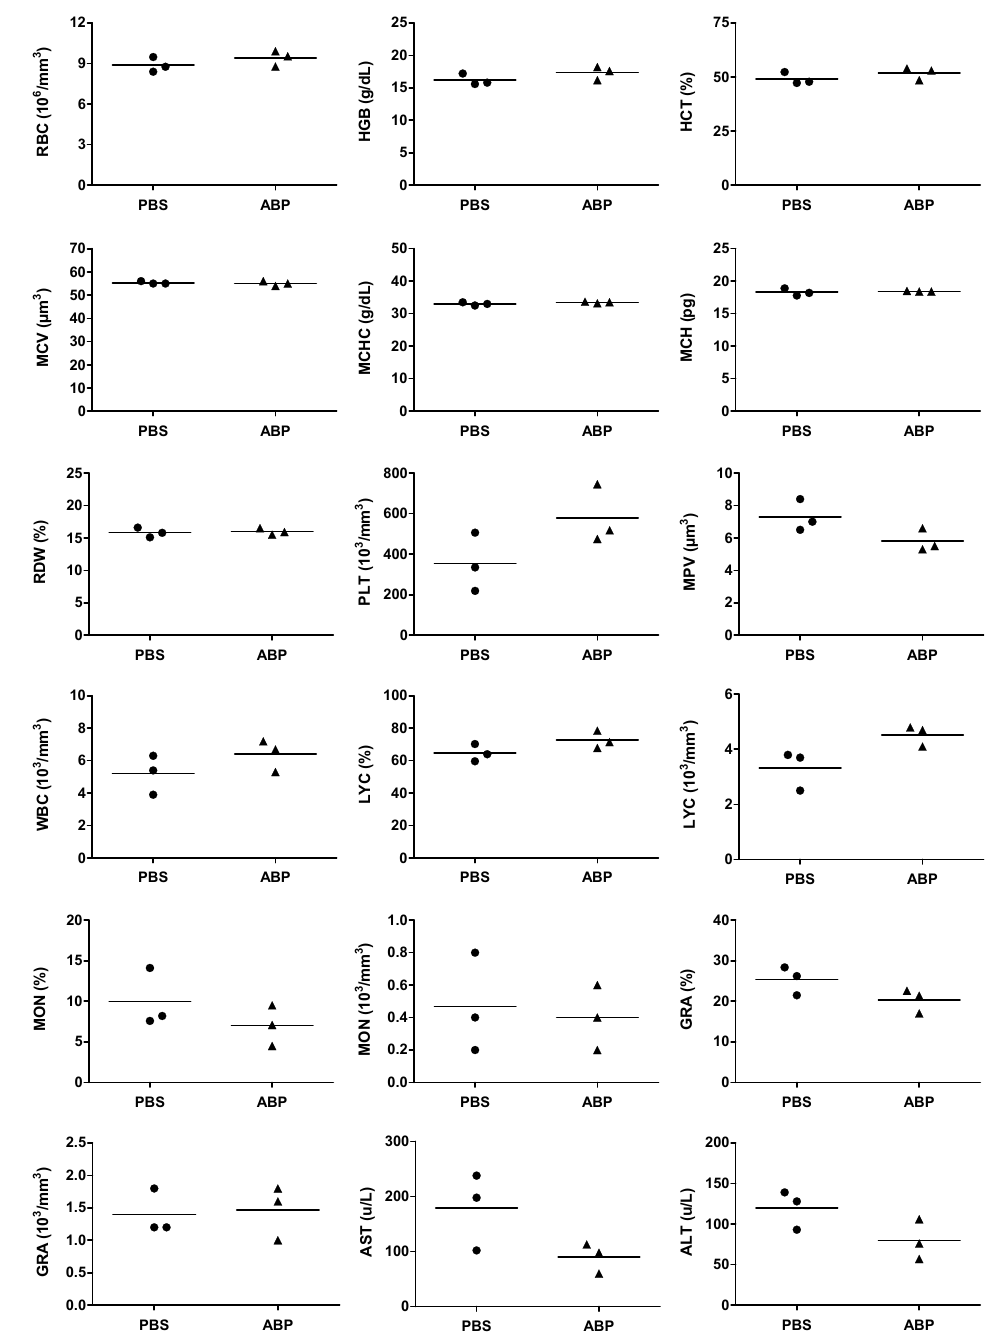
Figure 6. Quantification of the absolute numbers of red blood cells (RBC), hemoglobin (HGB), hematocrit (HCT), mean corpuscular volume (MCV), mean corpuscular hemoglobin concentration (MCHC), mean corpuscular hemoglobin (MCH), RBC distribution width (RDW), absolute numbers of platelets (PLT), mean platelet volume (MPV), absolute numbers of white blood cells (WBC), absolute numbers and percentages of lymphocytes (LYC), monocytes (MON), and granulocytes (GRA) in blood; quantification of the enzymatic activities of aspartate and alanine transaminases (AST and ALT) in plasma. Measurements have been performed 24 h after an IV injection of the ABP dendrimer at 10 mg / kg. Bars represent the mean of each group of n = 3